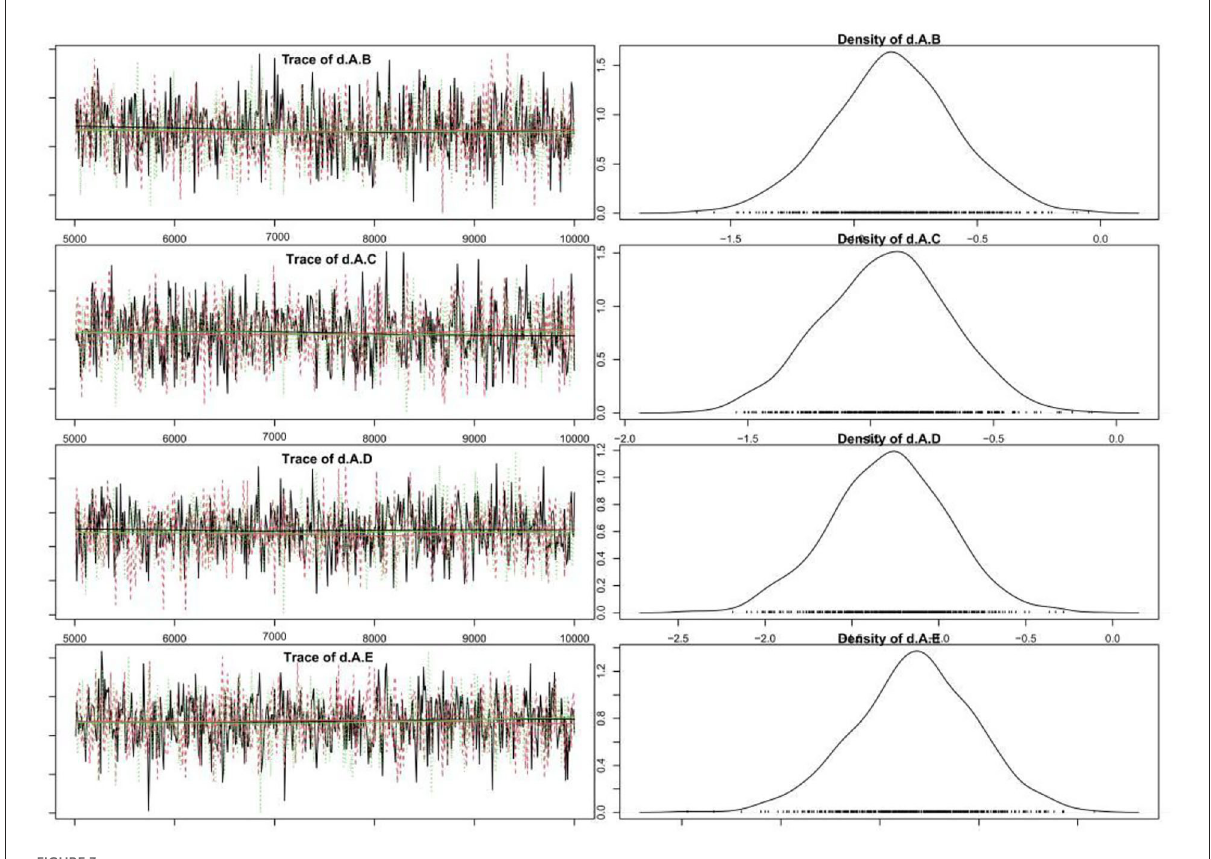
FIGURE3 Trajectory diagram and density